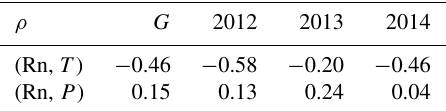
Table 1. Pearson correlation coefficient ( ρ ) between radon concen- tration time series (Rn) and temperature ( T ), pressure ( P ) time se- ries, evaluated both as global value ( G ) for the entire acquisition window and as annual value for 2012, 2013, 2014 separately. Rn concentration, T and P time series are filtered with a 14-day mov- ing